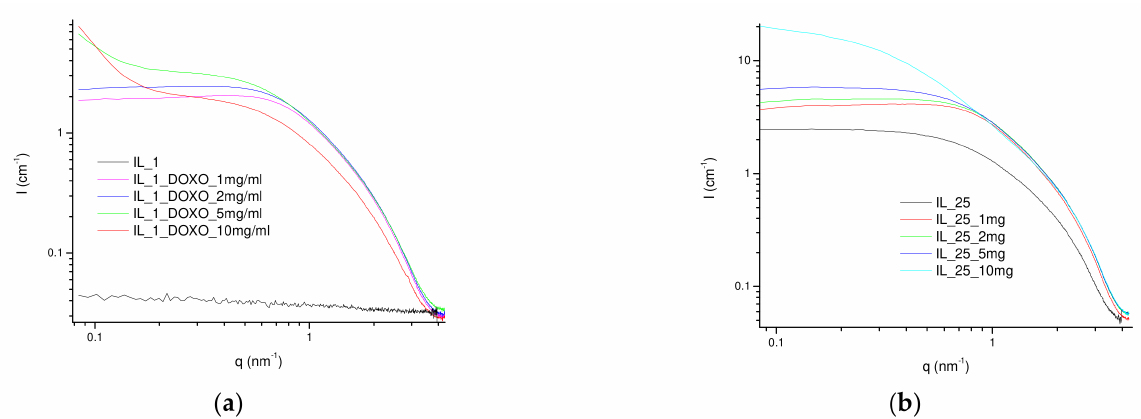
Figure 7. ( a ) SAXS profiles at room temperature (22 ◦ C) of ( a ) 1IL/Water loaded with DOX and ( b ) 25IL/Water loaded with DOX.